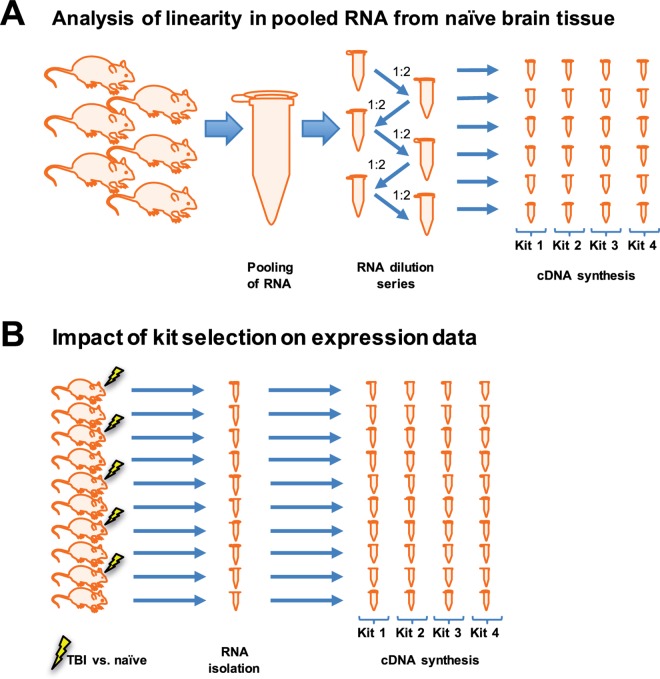
Schematic presentation of the study design.A) RNA of brain tissue from six naïve animals was extracted and pooled to create an identical dilution series. cDNA synthesis was then performed with each of the four kits. B) RNA of brain tissue from 6 naïve animals and 6 animals suffering traumatic brain injury was extracted. Each sample was reverse-transcribed, using all four kits, again ensuring the exact same starting material for each kit.